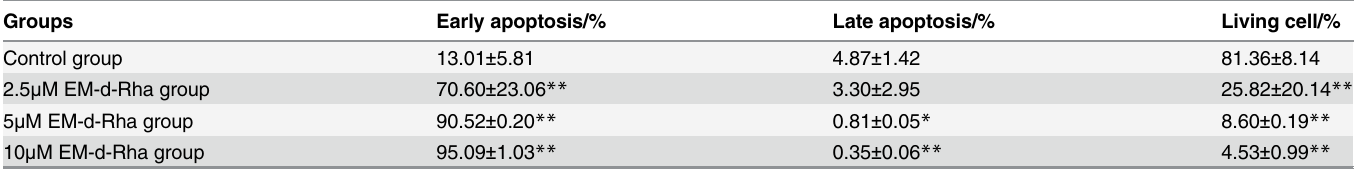
Table 5. The apoptosis rates of OVCAR-3 cells treated with different concentration EM-d-Rha.